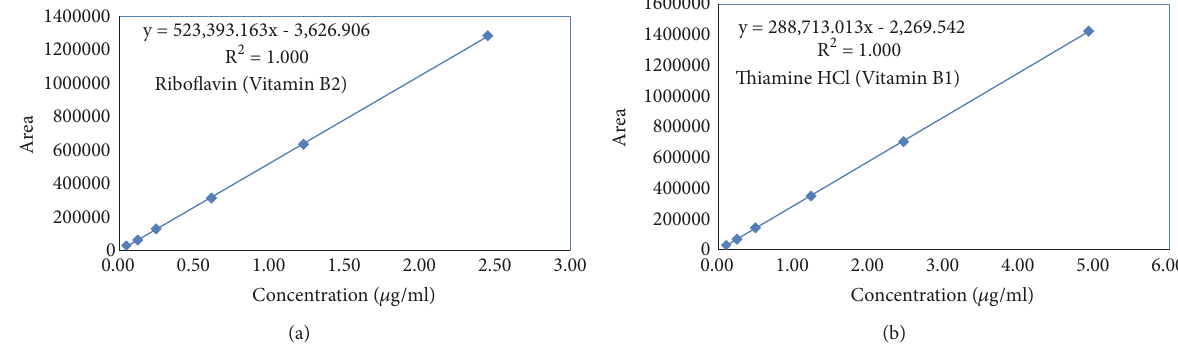
Figure 2: Linear curves for (a) riboflavin (0.05 𝜇 g /mL to 2.45 𝜇 g/mL) and (b) thiamine hydrochloride (0.10 𝜇 g/mL to 4.93 𝜇 g /mL).